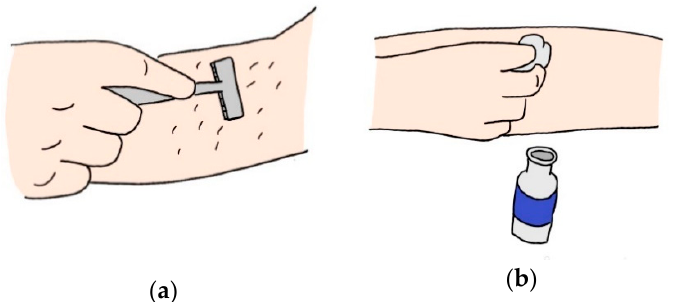
Figure 9. Preparations to reduce skin impedance: ( a ) shaving the attachment position; ( b ) disinfecting with an alcohol-soaked cotton.